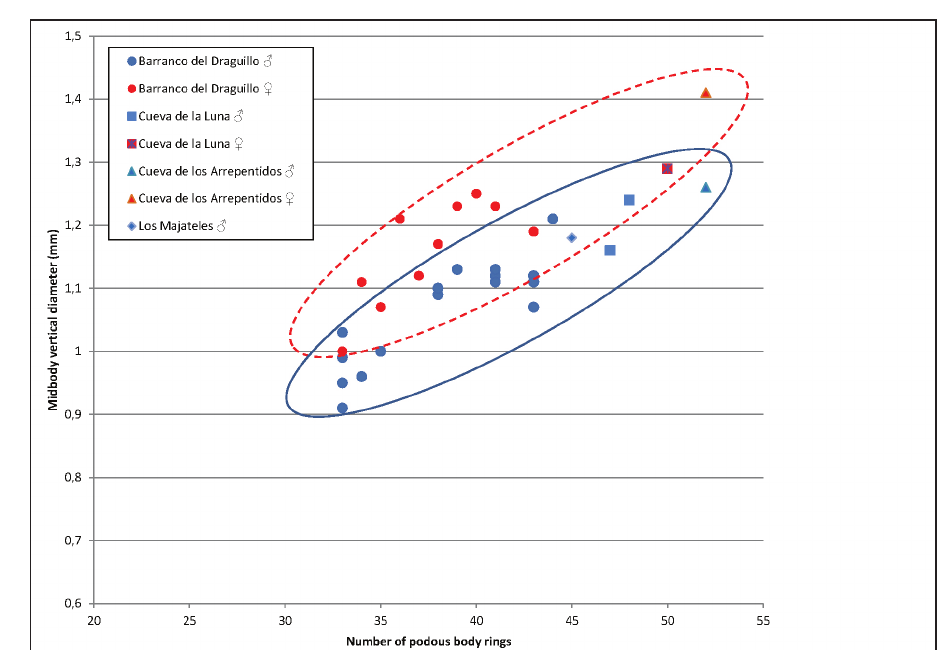
Fig. 1. Size diagram for Dolichoiulus typhlocanaria sp. nov. The diagram shows number of podous (leg-bearing) body rings (p.r., x axis) and vertical body diameter in mm (y axis). For a given number of podous rings D. typhlocanaria sp. nov. is thicker than the two other species (see Fig. 5), and females are thicker than males.